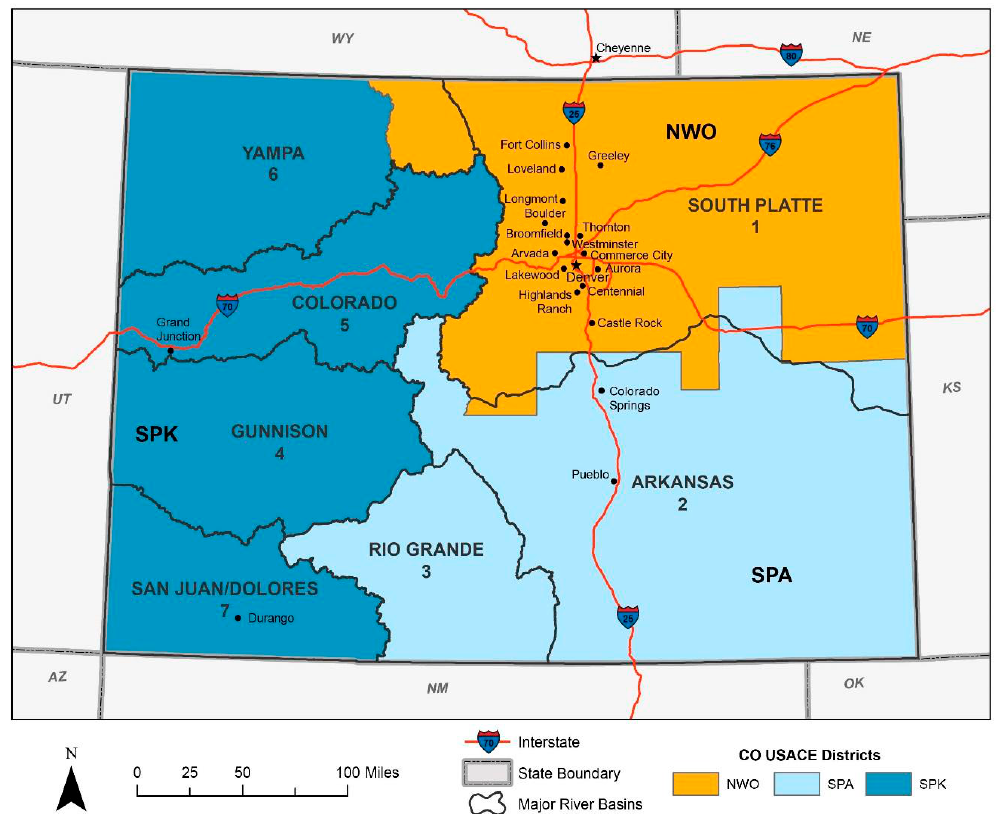
Figure 1. Colorado study area with state and federal regulatory boundaries relevant to stream mitigation. The three USACE Districts are Omaha (NWO), which is under the Northwest Division, and Albuquerque (SPA) and Sacramento (SPK), which are under the South Pacific Division (SPD). USACE field offices are located in Denver, Pueblo, Durango, and Grand